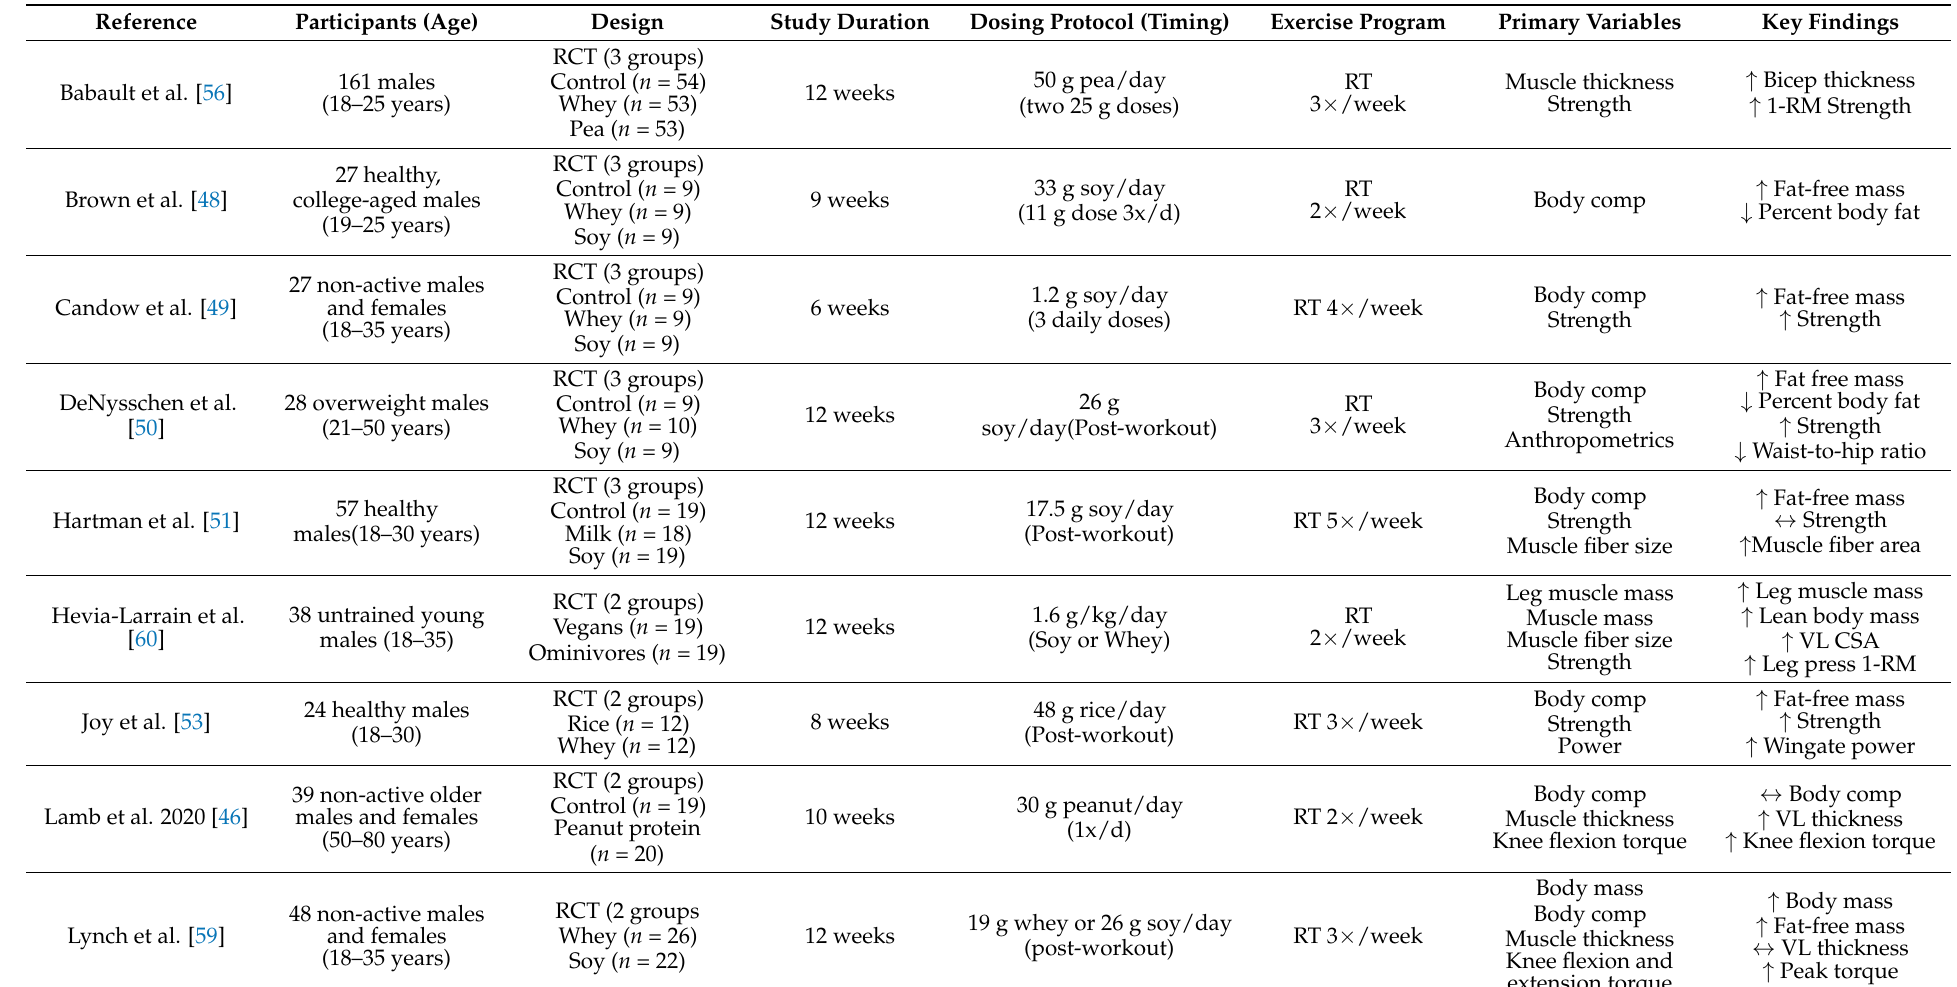
Table 2. Summary Table of Prolonged (Training) Examining Exercise Training Adaptations Using Plant Protein